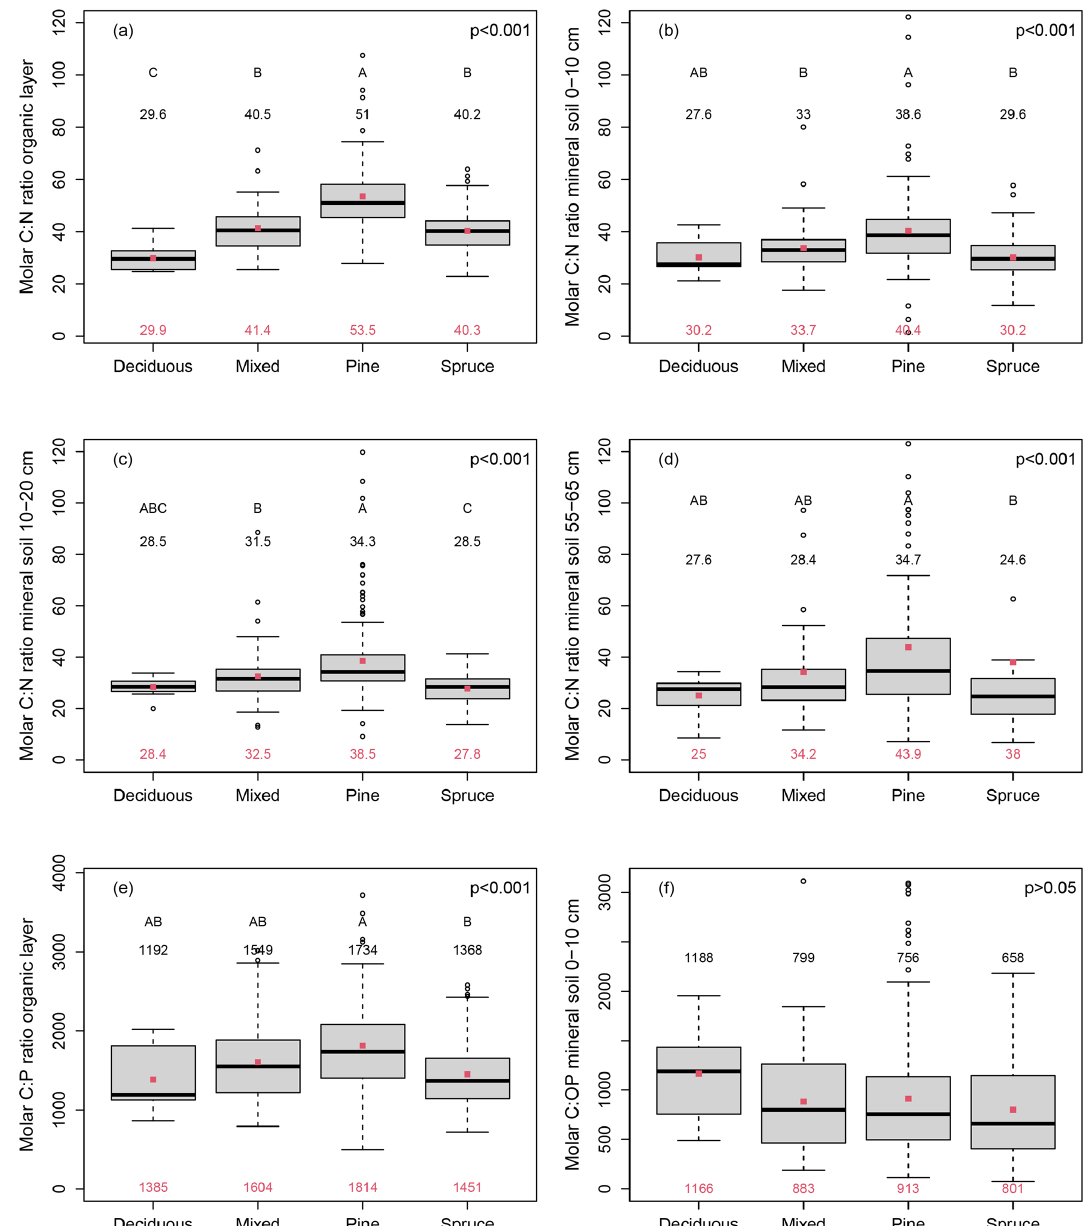
Figure 3. Molar carbon-to-nitrogen (C : N) ratio of the organic layer (a) and the mineral soil at 0–10cm depth (b) , 10–20cm depth (c) , and 55–65cm depth (d) , as well as the molar carbon-to-phosphorus (C : P) ratio of the organic layer (e) and the molar carbon-to-organic phosphorus (C : OP) ratio in the mineral soil at 0–10cm depth (f) depending on the dominant tree species (deciduous n = 10, mixed n = 67, pine n = 144, and spruce n = 88). Please notice that mixed refers to mixed pine and spruce forests. Black numbers give the median, and red dots and red numbers depict the arithmetic mean. Different capital letters indicate statistically significant differences ( p < 0 . 05) between plots with different dominant tree species, while the p value of the ANOVA is indicated in the right corner of each